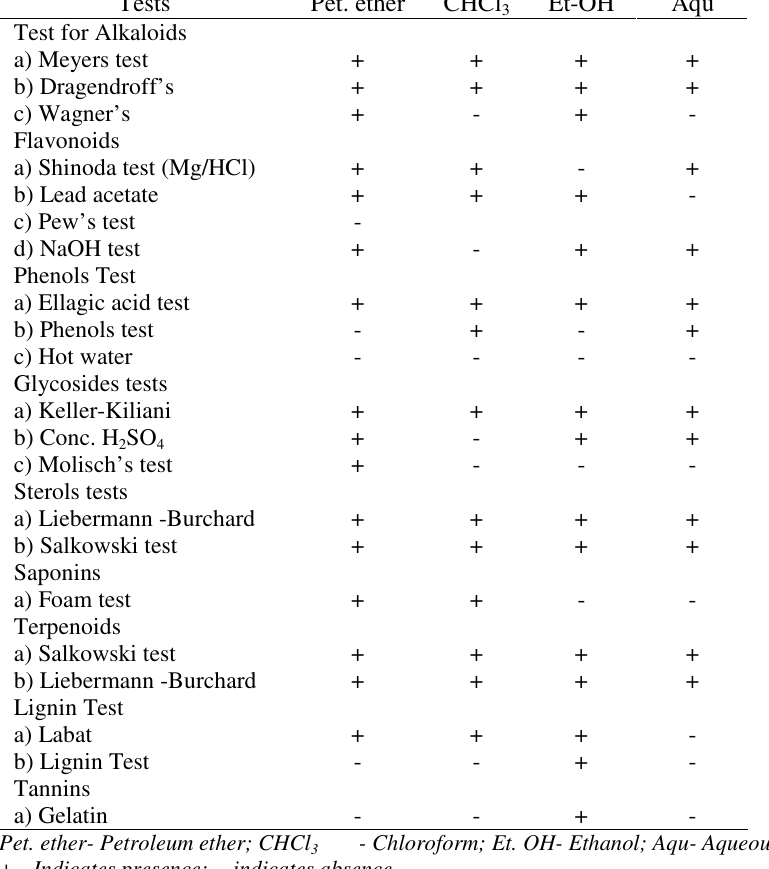
Table 1. Preliminary phytochemicals screening tests of secondary metabolites in Digera muricata.